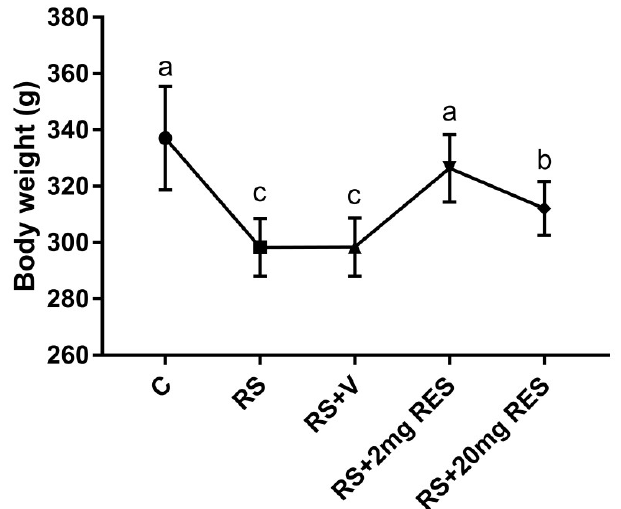
Figure 1. E ff ects of resveratrol on the body weights of non-stressed mice (C), restraint-stressed mice (RS), restraint-stressed mice treated with vehicle (RS + V), restraint-stressed mice treated with 2 mg / kg body weight of resveratrol (RS + 2 mg RES), and restraint-stressed mice treated with 20 mg / kg body weight of resveratrol (RS + 20 mg RES). Statistical di ff erences were determined by 1-way ANOVA followed by Tukey’s multiple-comparison test. Di ff erent superscript letters represent significant di ff erences among groups ( p < 0.05).